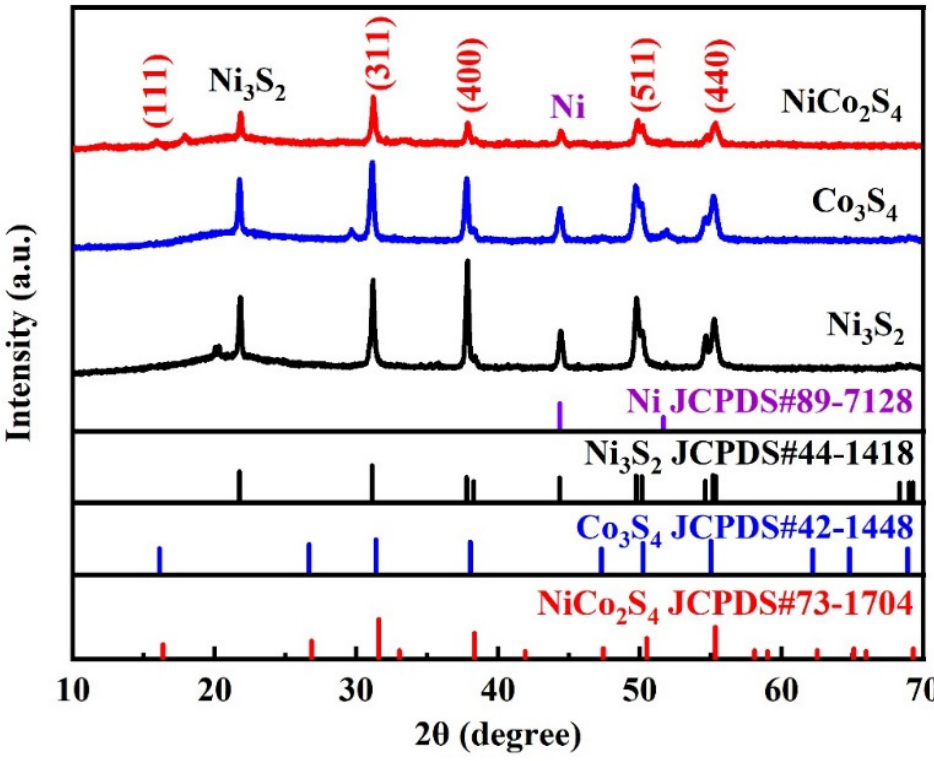
Figure 2. XRD pa tt erns of samples. Figure 2. XRD patterns of